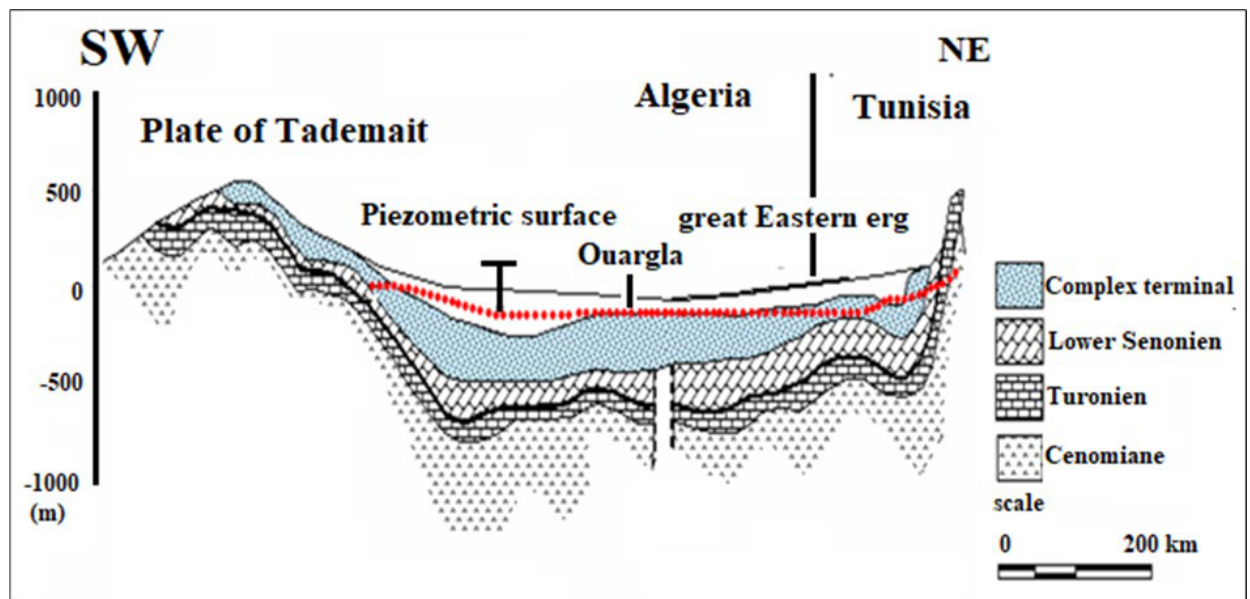
Figure 2. Cross-section of the hydrogeological layers in the study area.